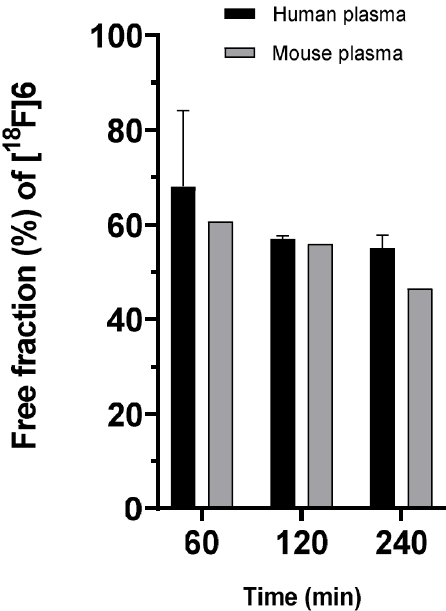
Figure 2. Free fraction of the radiotracer [ 18 F]SiFA-Tz ([ 18 F] 6 ) during 240 min incubation in human and mouse plasma demonstrated comparable profiles with ~50% of the radioactivity in the free fraction at the end of incubation.